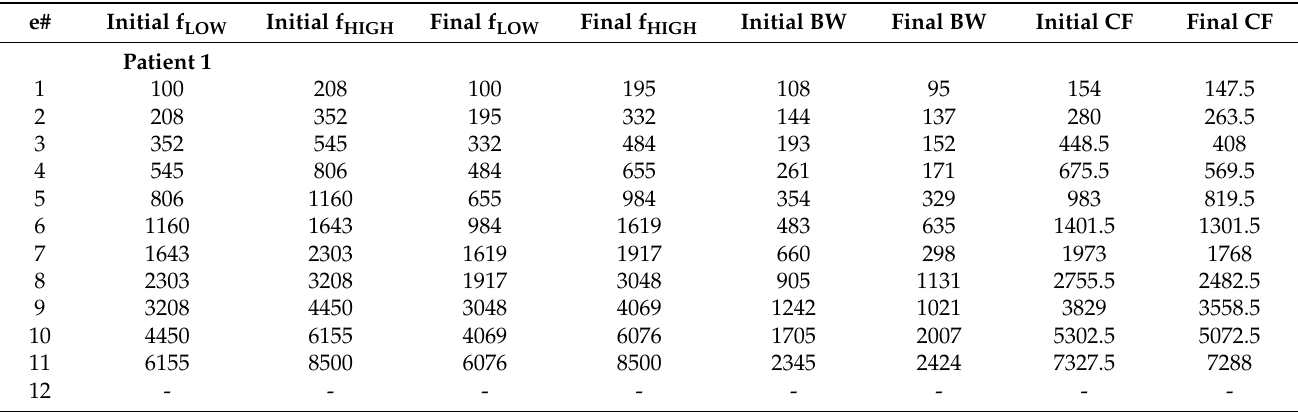
Table A1. Frequency bands adjustments with the evolutionary algorithm. Values are expressed in Hertz, e# (electrode number), BW (Band Width), f LOW (Lower Limit, Hz), f HIGH (Upper Limit, Hz), CF (Center Frequency, Hz). -: deactivated